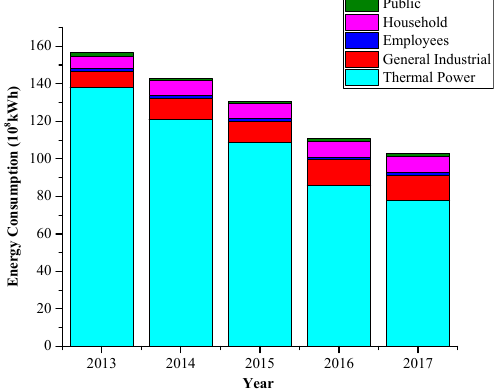
Water 2020 , 12 , x FOR PEER REVIEW 13 of 21